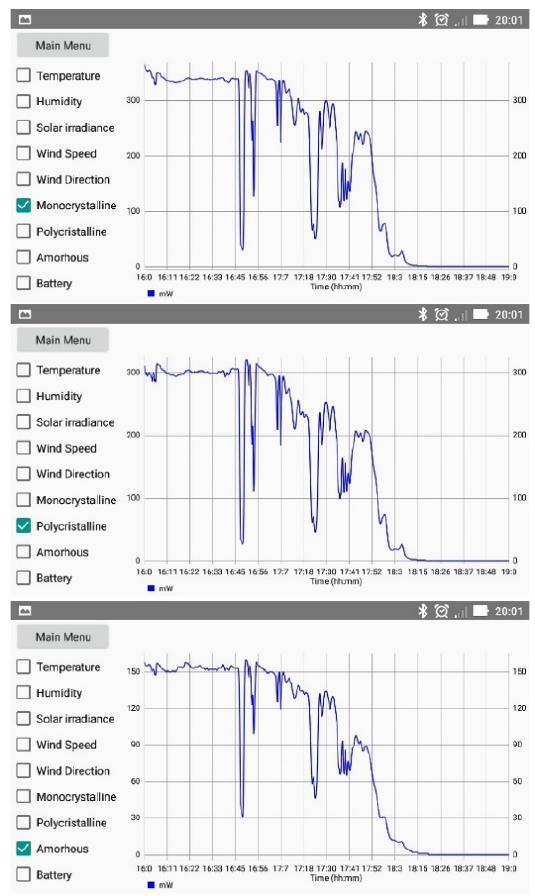
Figure 16. Power produced by each PV module installed in the weather station for 3